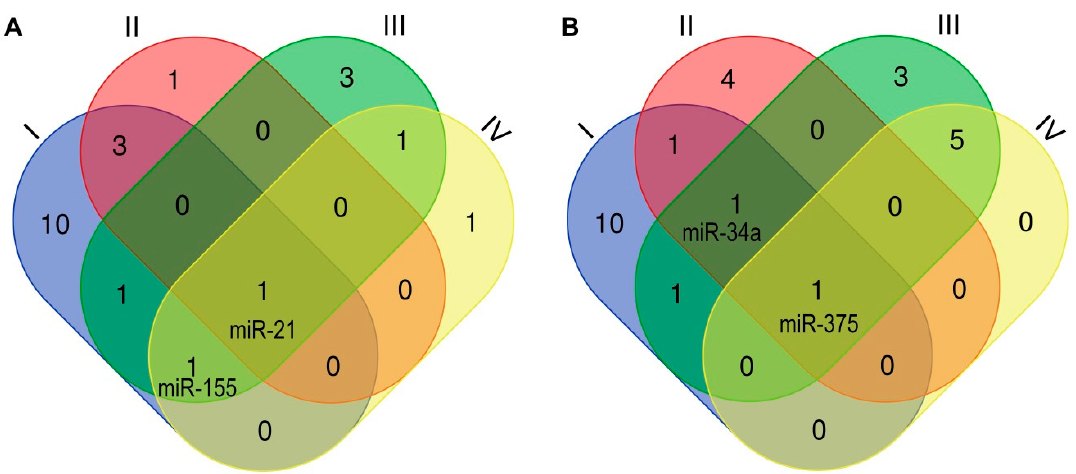
Figure 1. Venn diagram showing upregulated ( A ) and downregulated ( B ) miRNAs depending on human papillomavirus (HPV) infection (I), histological type of cervical cancer (CC) (II), the risk of metastasis (III), and susceptibility to therapy (IV).